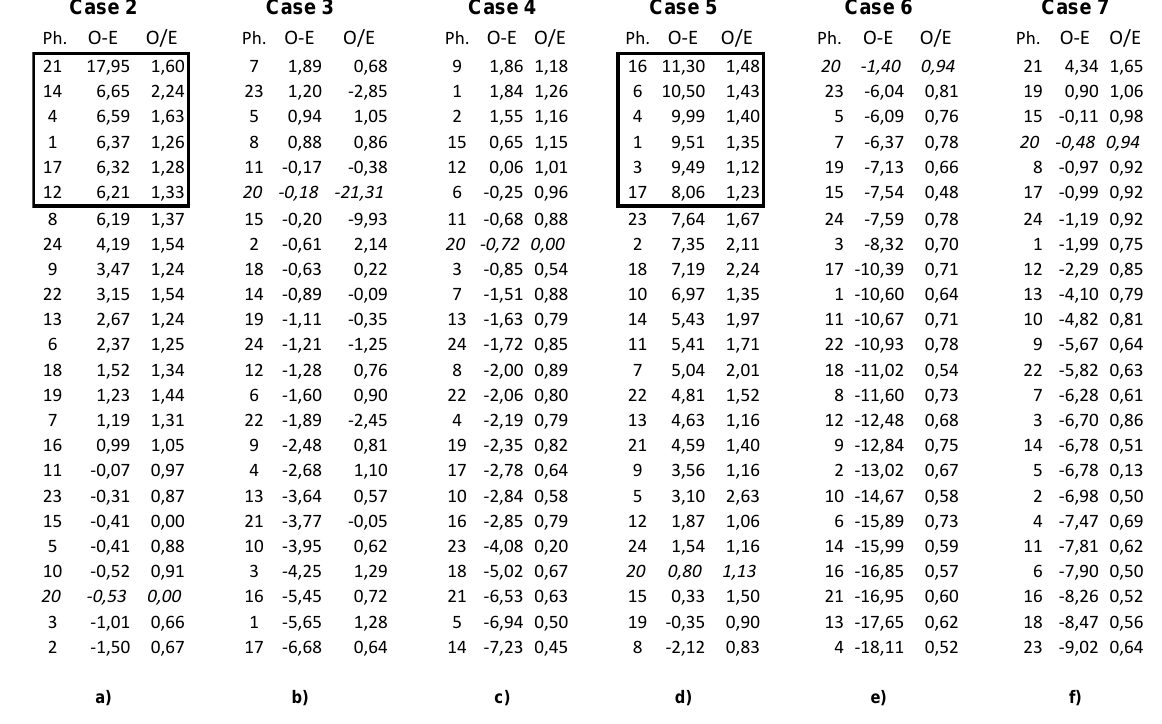
Table 5 Ranking of the different phenomena/statements in respect of case 2-7 based on observed frequencies (O) minus expected frequencies